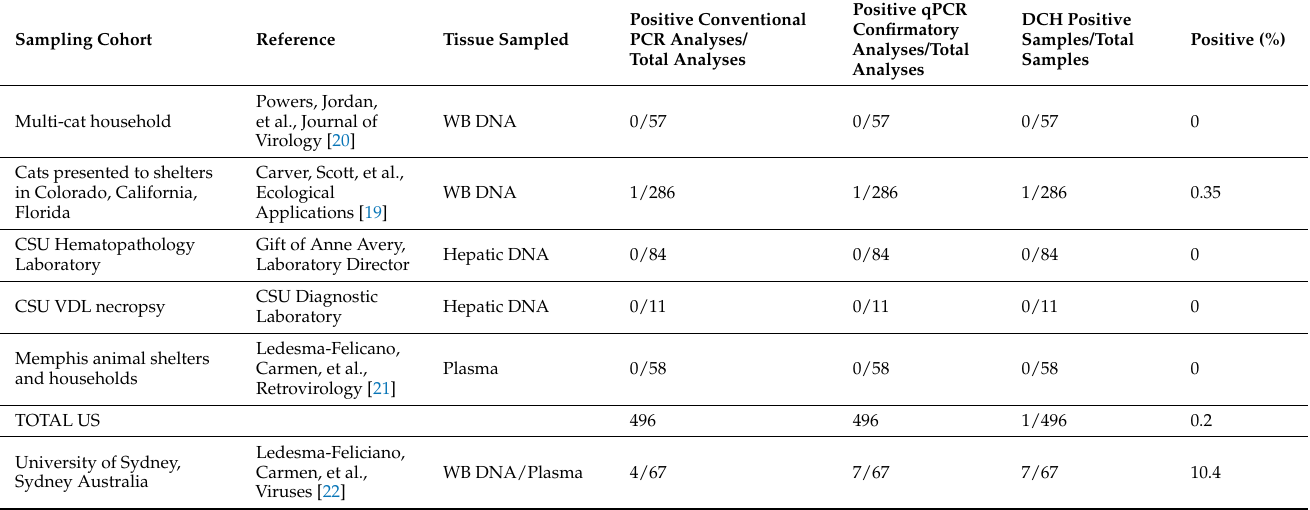
Table 1. Conventional and qPCR detection of DCH in cat samples reveals one positive sample out of 496 samples from diverse U.S. populations and seven positive samples out of 67 samples from Australia. WB = whole blood. One positive sample identified from Ventura County shelters in California was cloned for complete genome sequencing as described below. Of 67 samples from paired whole blood and plasma from Australian domestic cat samples, 7 were identified and 3 of these were also sequenced. Conventional PCR was executed via HGAP primers as described by Aghazadeh et al. [1]. qPCR was performed using FHBV primers and protocols as described by Lanave et al.